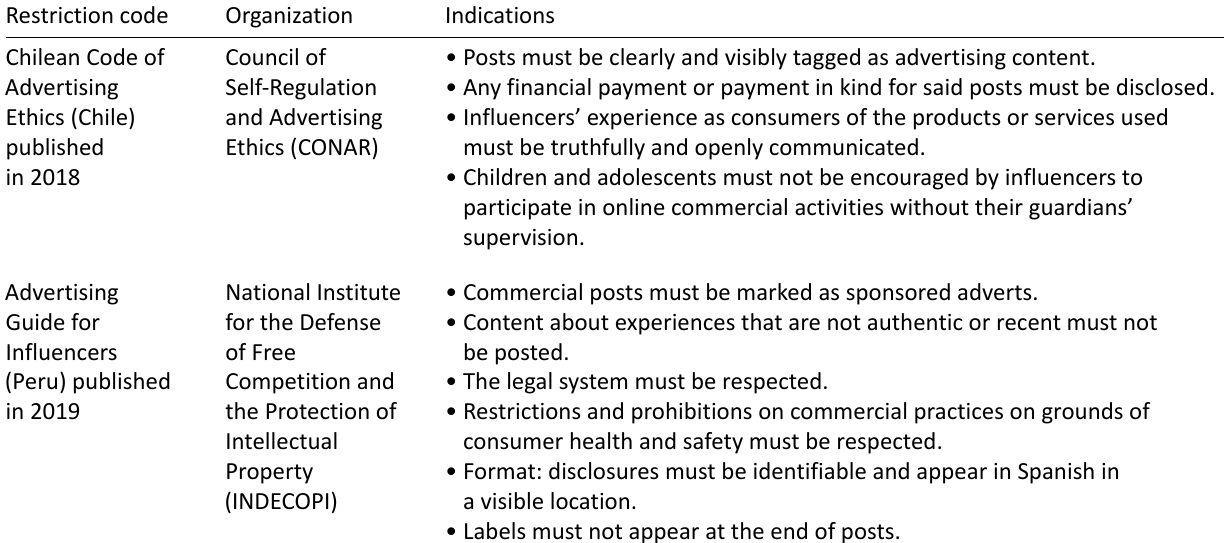
Table 1. Ethical codes for influencers in Latin